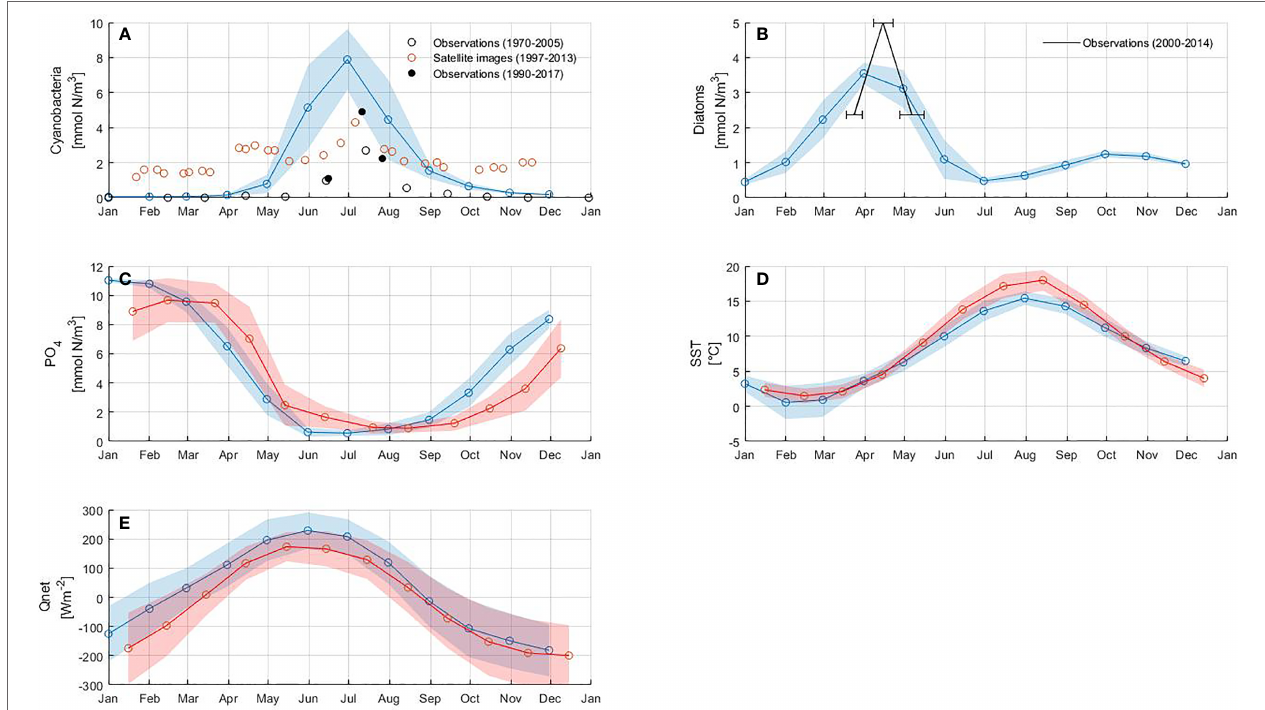
FIGURE 4 | Model results: (A) cyanobacteria, (B) diatoms, (C) phosphate concentration calculated from nitrogen using N:P ratio, (D) sea surface temperature (SST) and (E) net heat flux (Qnet).The circles connected with a solid line represent monthly mean values of the model results (blue) and the reference data sets (red), respectively. The shaded area corresponds to the standard deviation of each variable. Horizontal error bars in (B) represent the standard deviation of bloom occurrence dates. Details of the data sets used as reference are reported in Table 3